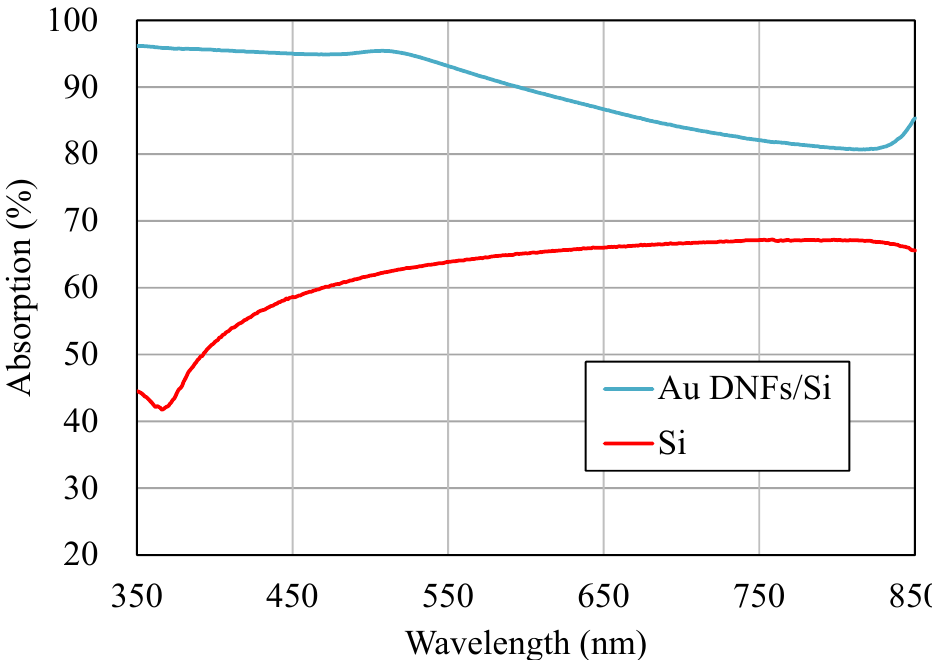
Figure 3. Absorption spectra of Au DNFs / Si and Si chips.